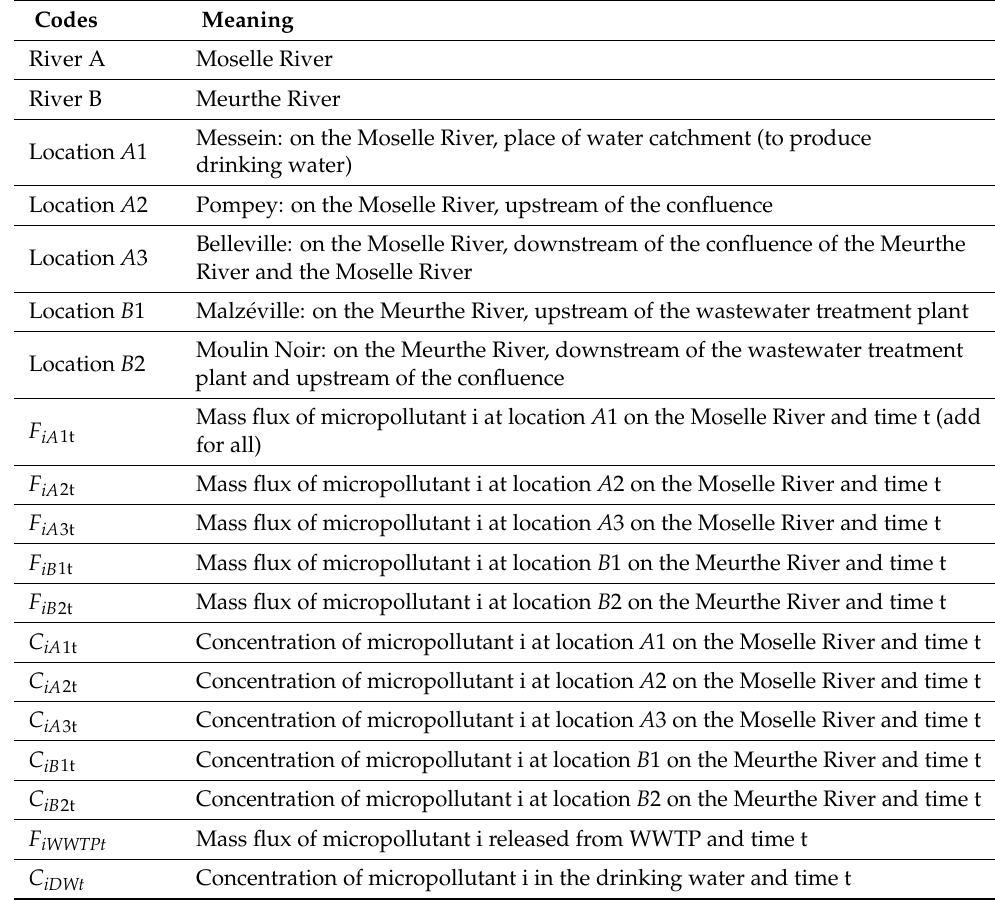
Table 1. The codes used to represent rivers, locations, and calculation